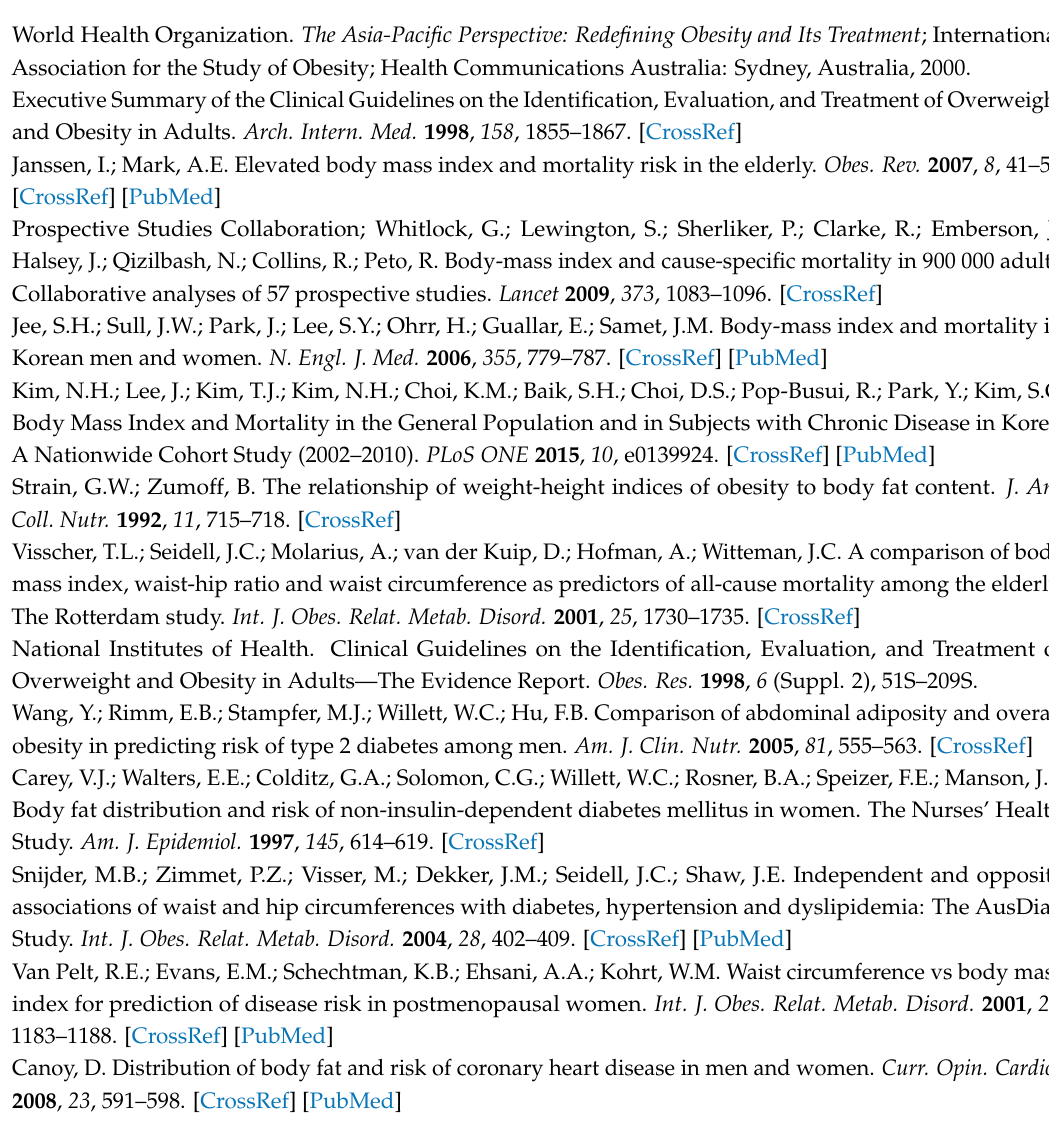
Figure S1: Smoothed hazard ratio for waist circumference; Table S1: Age and sex standardized incidence rate based on Korea 2010